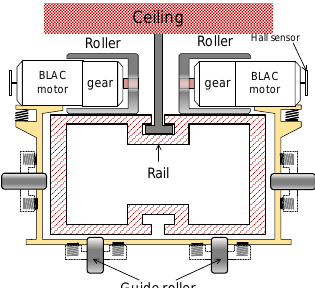
Figure 3. Proposed overhang-type rail mover using dual motors.